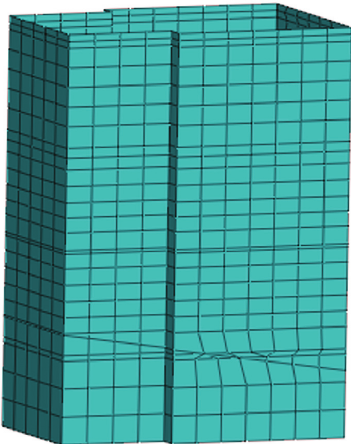
Figure 7: Schematic diagram of the bottom-level wall-to-wall